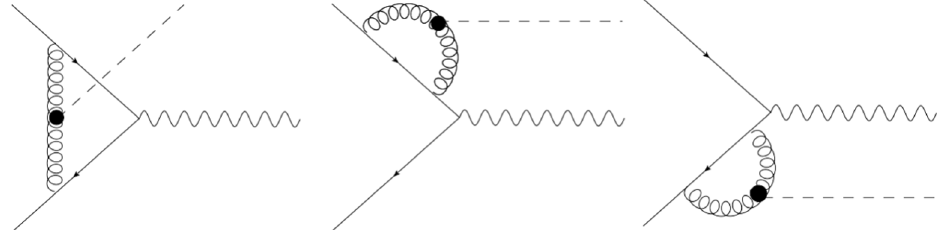
Figure 9 . The class-I diagrams of the top-quark contributions to q (cid:22) q ! ZH in the limit m t ! 1 in the leading power approximation. The black blob indicates the e(cid:11)ective Hgg